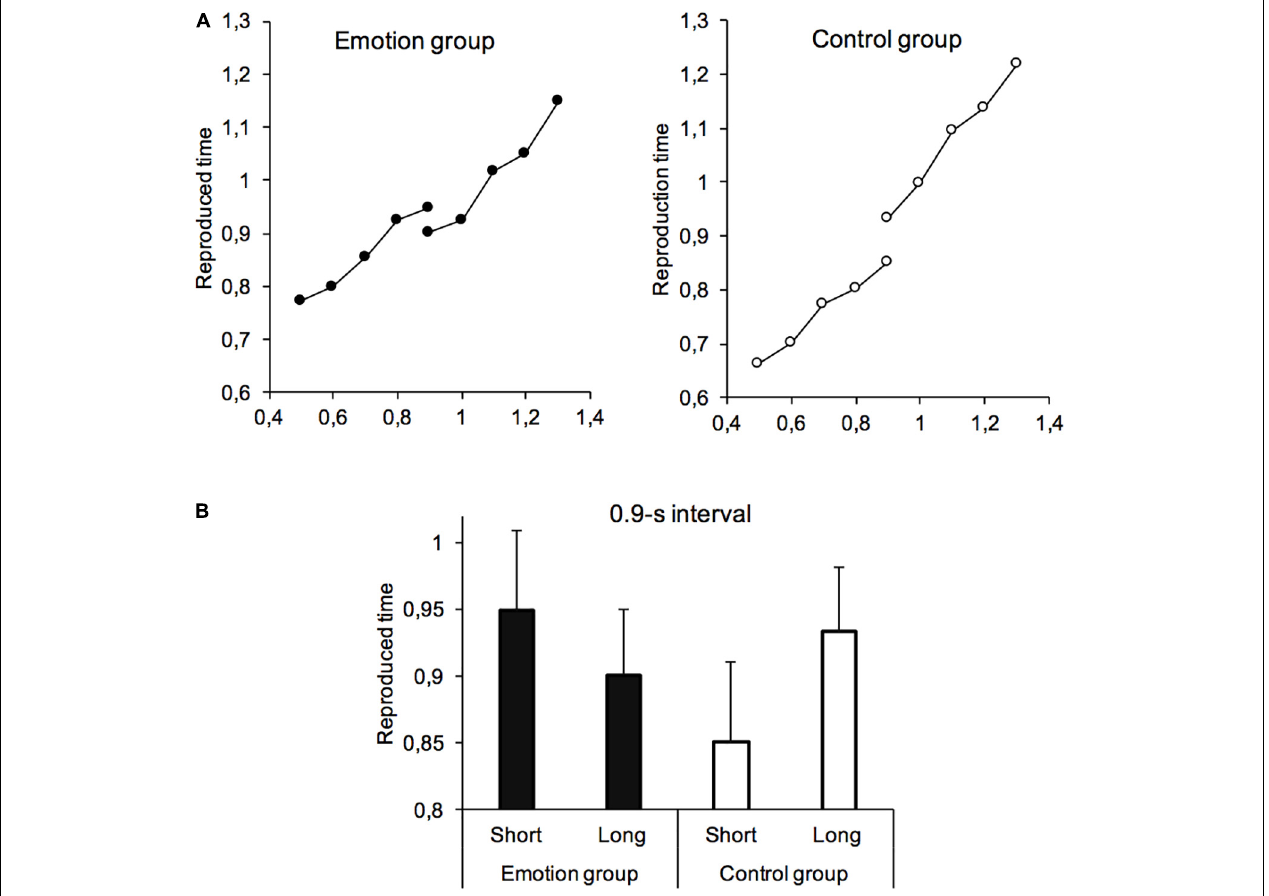
FIGURE 2 | Reproduced interval. (A) Reproduced time (seconds) plotted against the sample intervals for the temporal task with the distribution of short intervals (Short) and that with the distribution of long intervals (Long) for the control group and the emotion group. (B) Reproduced interval for the 0.9-s overlapping interval for the Short and the Long temporal